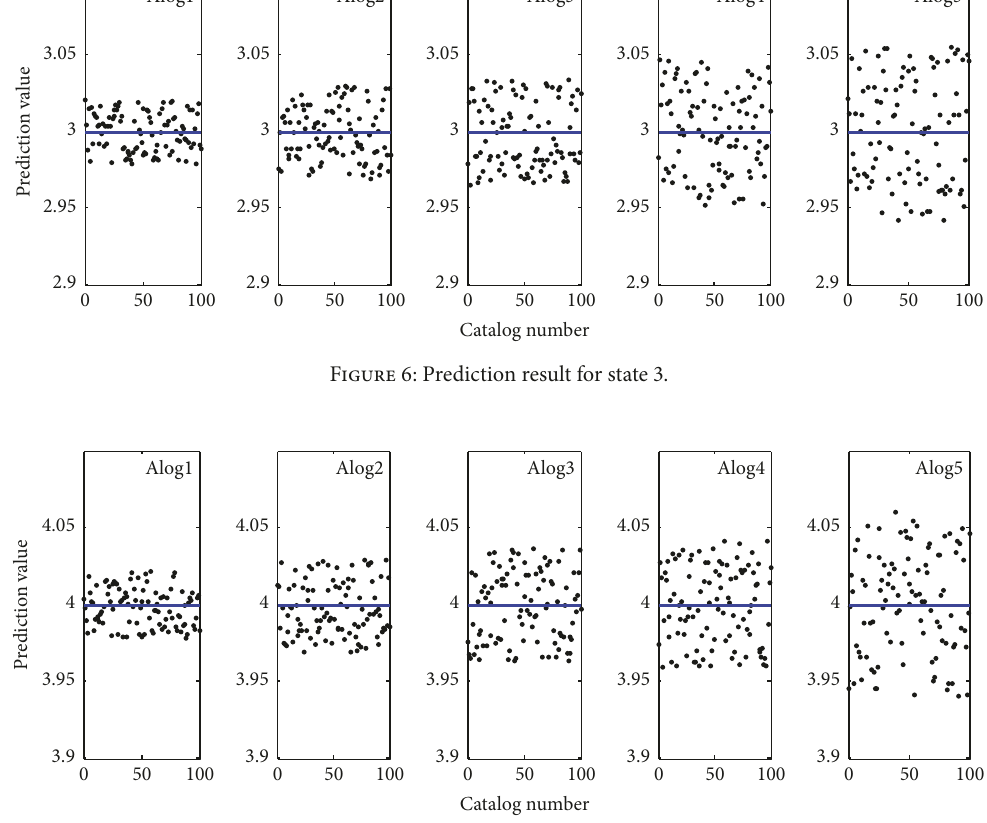
Figure 7: Prediction result for state